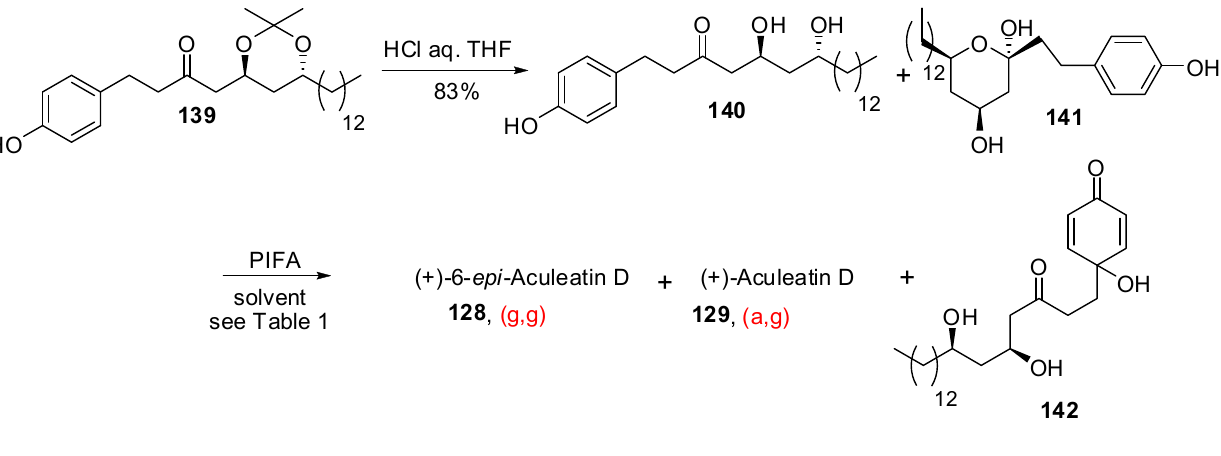
Table 1. Stereochemical dependence on reaction